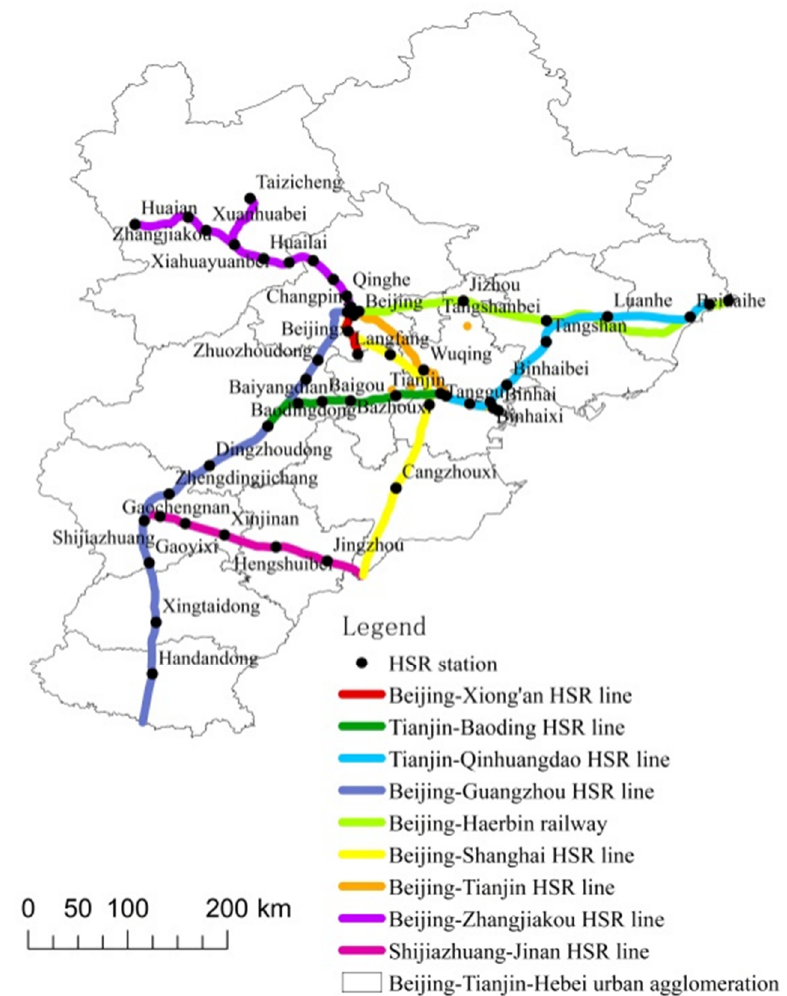
Figure 2. Distribution of HSR lines and stations in the Beijing-Tianjin-Hebei urban agglomeration (2020).